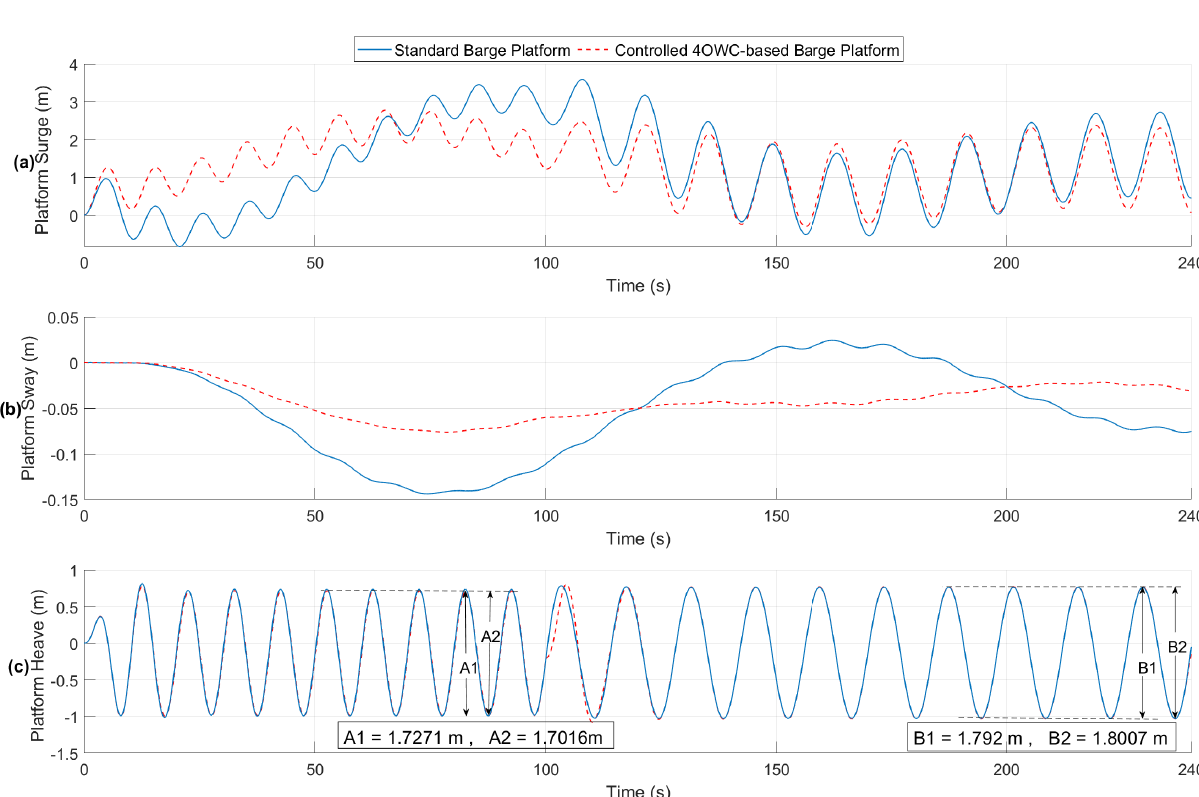
Figure 8. Platforms’ translational modes. ( a ) Surge. ( b ) Sway. ( c ) Heave.